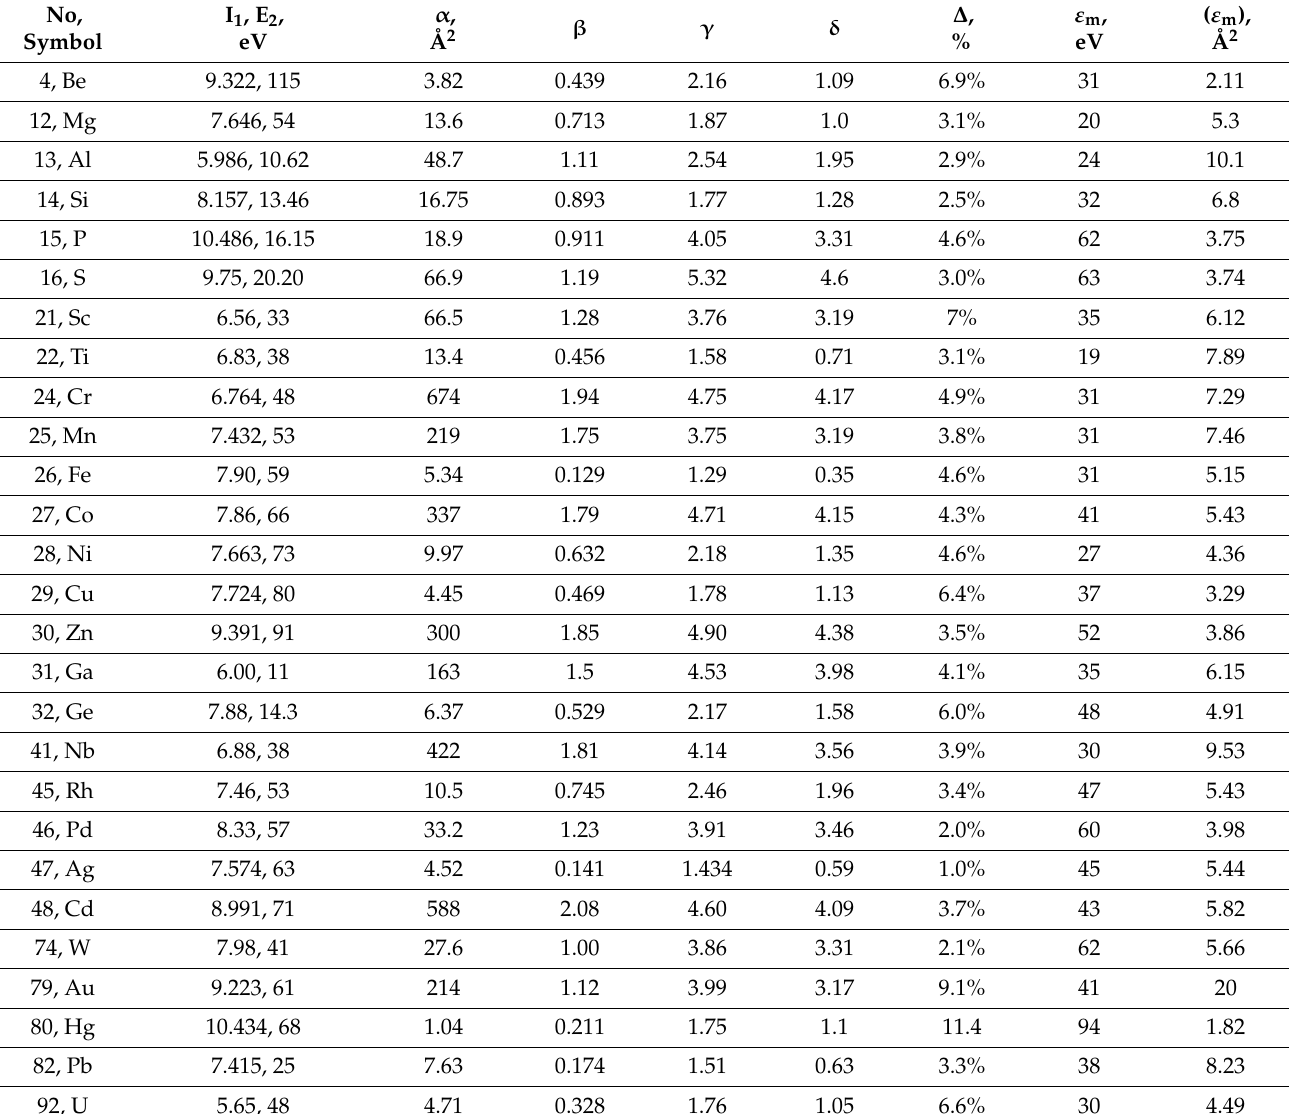
Table 5. Parameter values for approximating the ionization cross sections of various